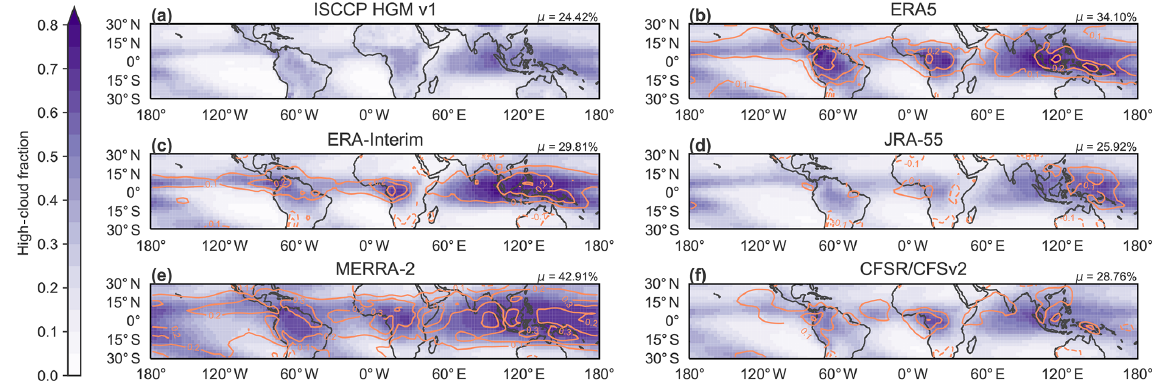
Figure 1. Climatological mean spatial distribution of high-cloud cover (HCC) for (a) ISCCP HGM, (b) ERA5, (c) ERA-Interim, (d) JRA-55, (e) MERRA-2, and (f) CFSR/CFSv2 over 1984–2014. Differences relative to ISCCP HGM are shown for each reanalysis as orange contours (dashed for negative values) at intervals of 0.1. The area-weighted tropical-mean (30 ◦ S–30 ◦ N) HCC based on each product is shown at the upper-right corner of the corresponding panel.